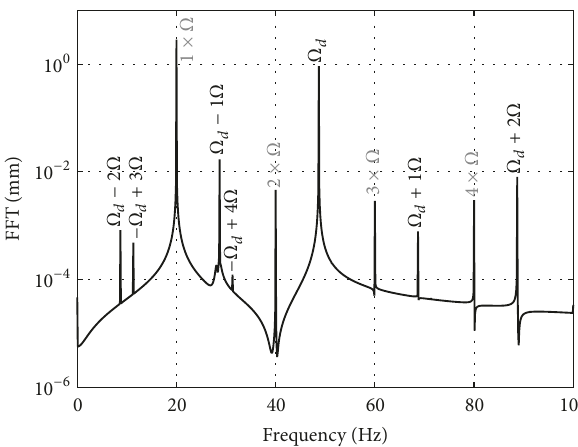
Figure 6: Identification of the combination resonances in the FFT of the system vibration responses with 10% crack